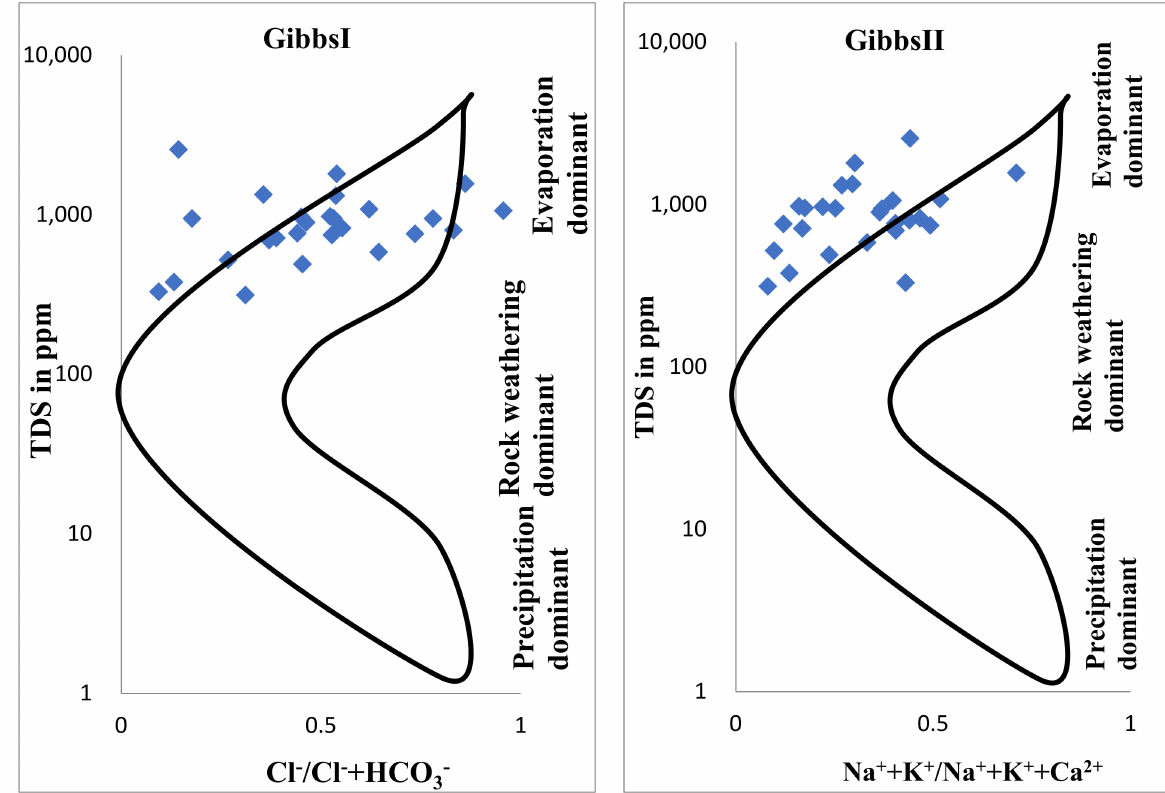
Figure 4. Gibbs diagram showed the dominant process.